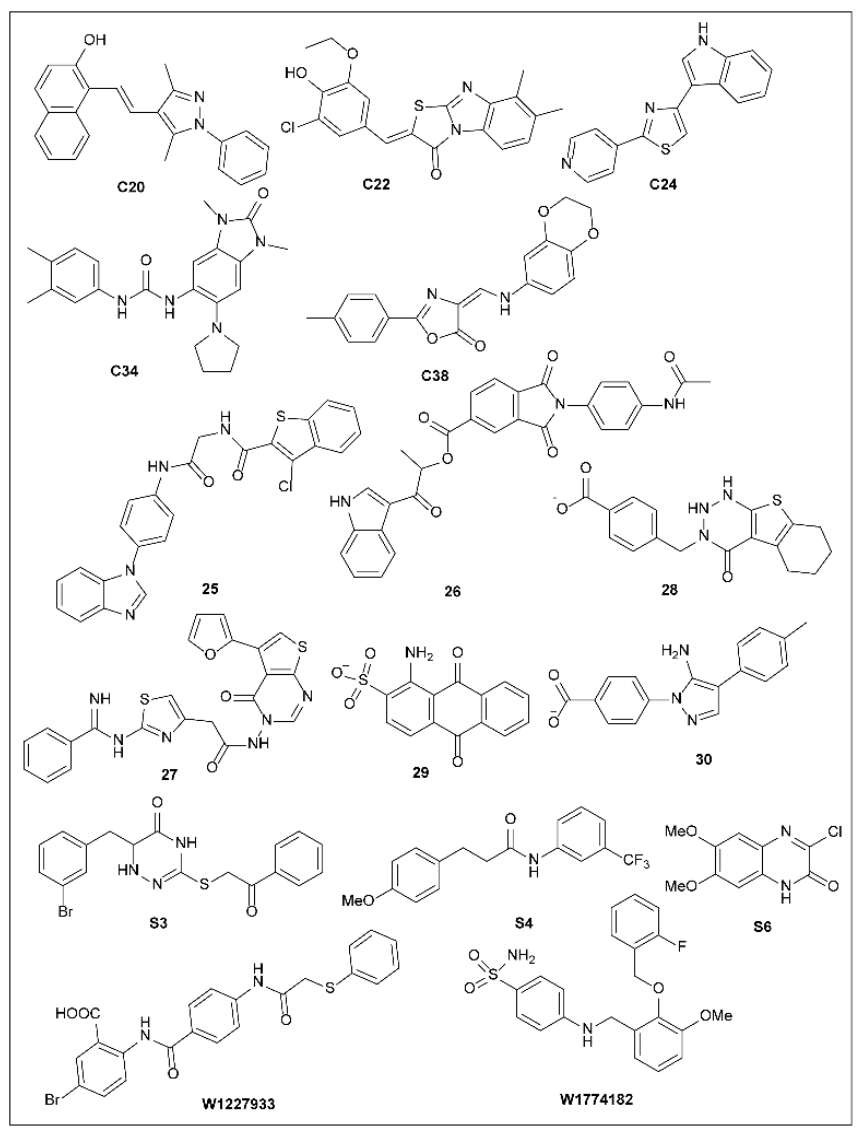
Figure 9. Structures of other synthetic T3SS inhibitors.